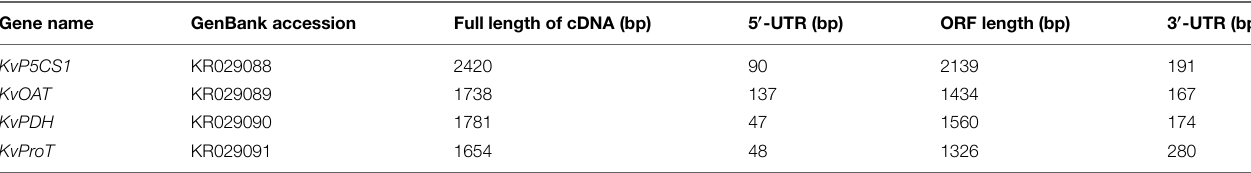
TABLE 1 | Isolated genes related to proline metabolism in Kosteletzkya virginica .